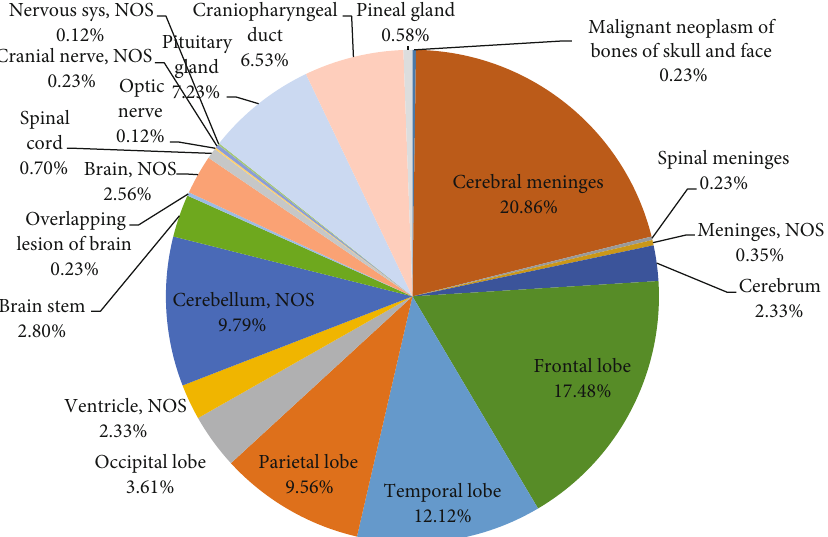
Figure 5: Distribution of all primary CNS tumors by anatomic site for adults ( > 18